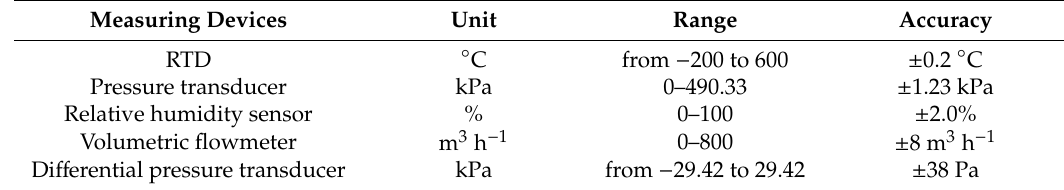
Figure 2. Pictures of heat exchanger element: ( a ) flow configuration; ( b ) specific dimension of the heat exchanger element. Table 1. Specifications and accuracies of measuring devices.